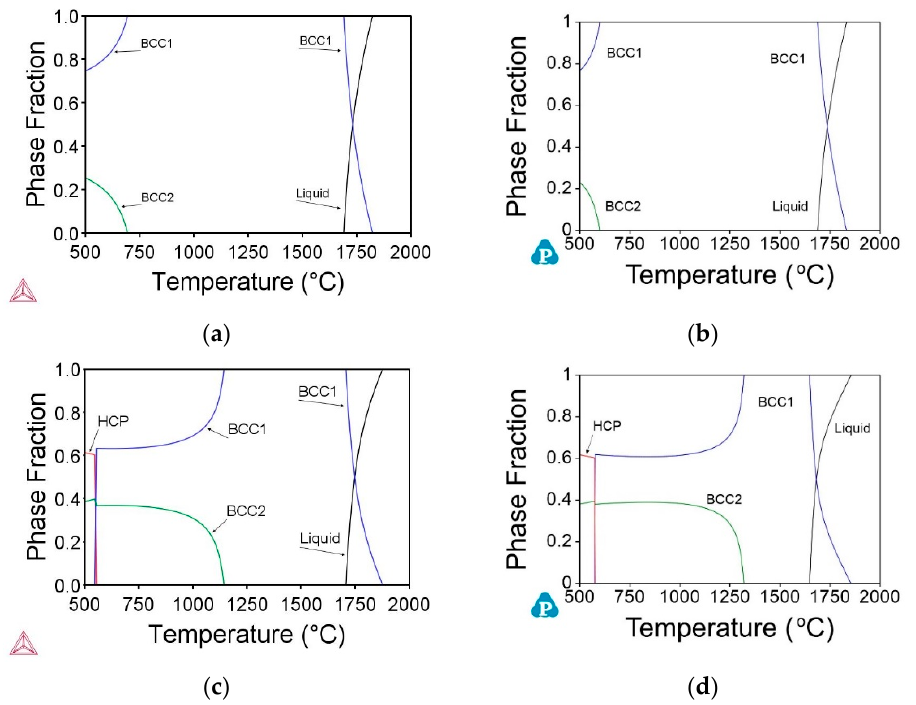
Figure 14. Equilibrium phase diagrams of ( a , b ) NbTiZr and ( c , d ) TaTiZr, calculated using the ( a , c ) TCHEA4.1 database and ( b , d ) PanNb2020 database. TCHEA4.1 database and ( b , d ) PanNb2020